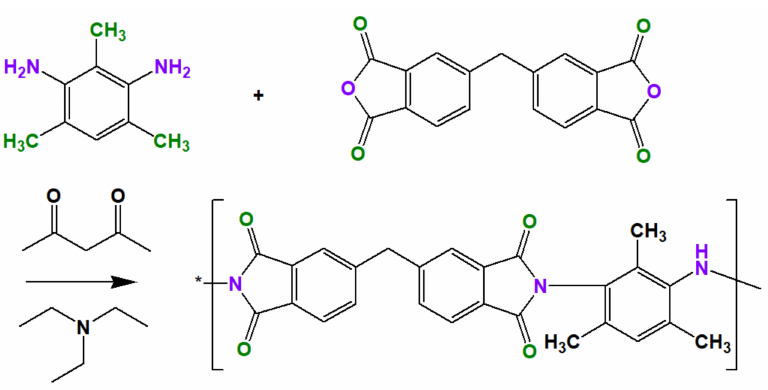
Figure 1. Reaction scheme for the synthesis of ODPA-TMPDA